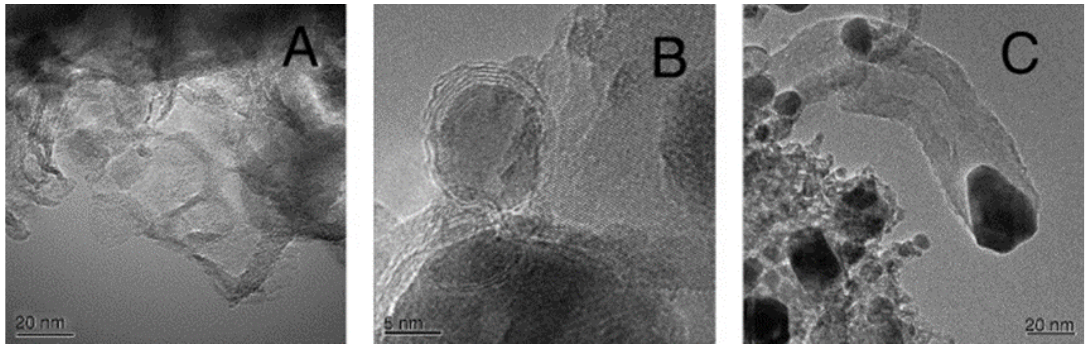
Figure 4. Electron microscopy images (Philips CM200 FEG TEM) of pyrolytic carbon on a MgAl 2 O 4 carrier ( A ), encapsulating carbon ( B ), and whisker carbon ( C ) on Ni/MgAl 2 O 4 reforming catalysts. Reprinted from